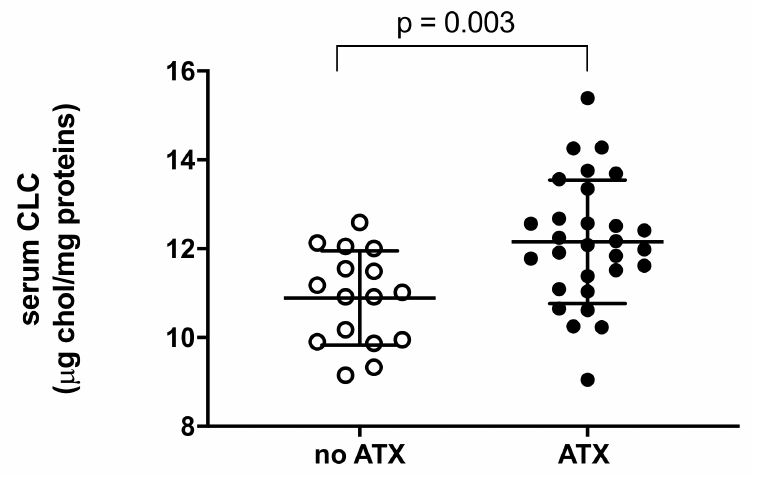
Figure 2. Serum cholesterol efflux capacity (CLC) in FH subjects not presenting or presenting ATX. Each point of the graph represents the average percentage of triplicate analyses for each sample. The average of each group is represented by a horizontal, solid